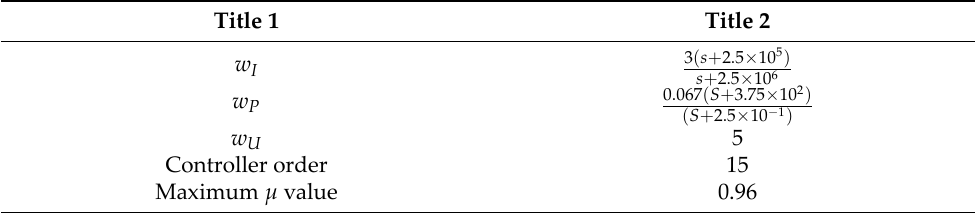
Table 2. µ ‑Synthesis Controller